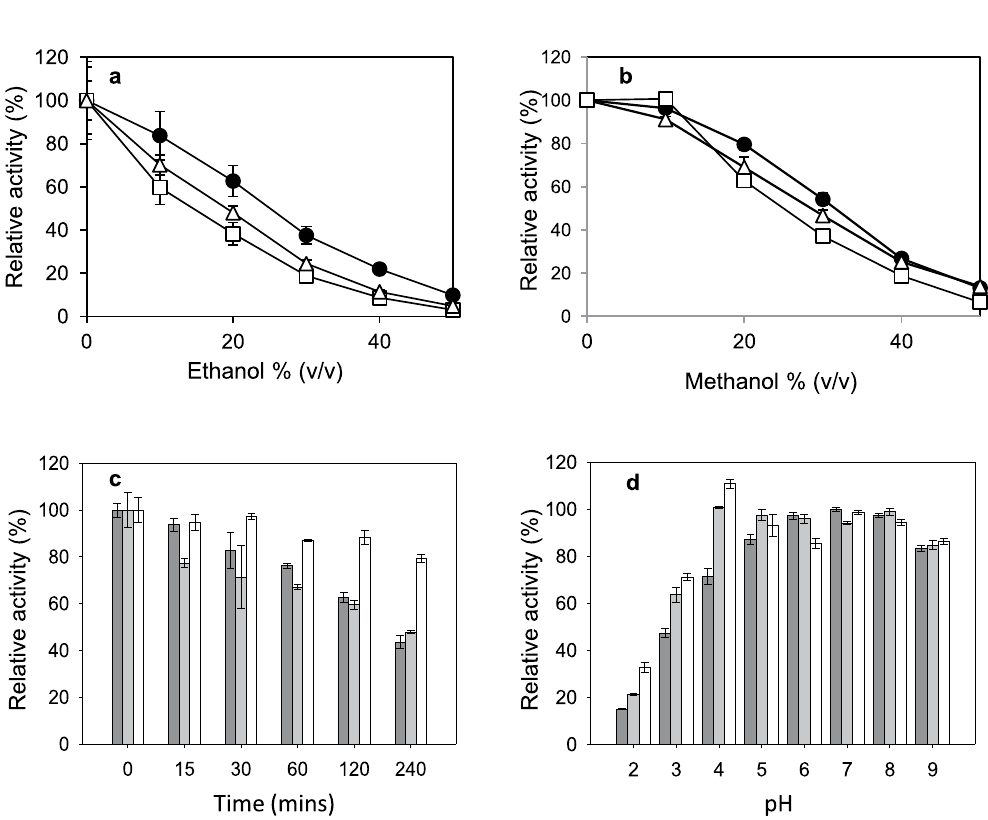
Figure 3. Activity at different concentrations of ethanol ( a ) or methanol ( b ) of purified domain-swap laccase (black circles) compared with purified wild-type parent-types PcL (white triangles) and PM1L (white squares); and stabilities in 40% methanol at different times ( c ) and after 6 h incubation at different pH ( d ) of purified domain-swap and OB1 and 3PO parent laccases. Bars from left to right: purified OB1, 3PO and domain-swap